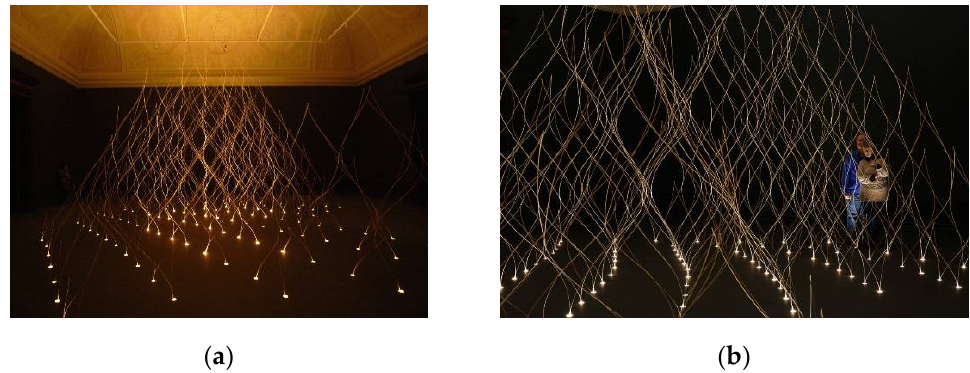
Figure 4. Kengo Kuma, Sensing Space, 2014. ( a ) Kuma’s installation ( b ) Kuma’s installation (Photos: James Harris).